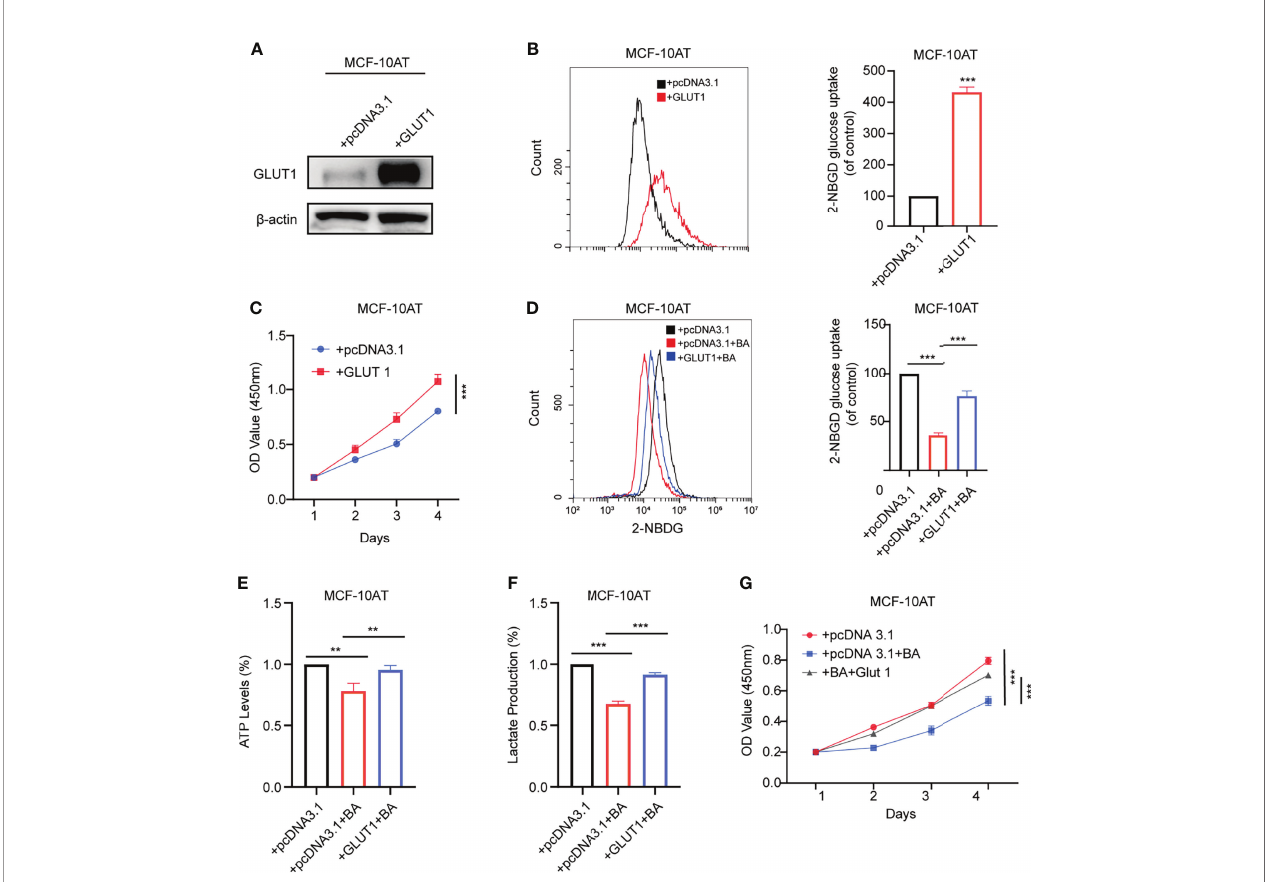
FIGURE 5 | GLUT1 mediates b -BA regulated glycolysis suppression. (A) The overexpression level of GLUT1 protein was detected by Western blot. (B) The 2- NBDG glucose uptake levels of GLUT1 overexpressing and its corresponding control cells were detected by FACS. Statistics are shown in the right panel as mean fl uorescent intensity ± S.D. (C) Cell viability was detected by CCK8 assay in GLUT1 overexpressing and its corresponding control cells. The glucose uptake level (D) ATP levels (E) , lactate production (F) , and cell viability (G) were measured in the group of MCF-10AT+pcDNA3.1, MCF-10AT+pcDNA3.1+BA, and MCF-10AT+ GLUT1+BA, respectively. Data were shown as the mean ± S.D from independent experiments. ** p < 0.01 and *** p <